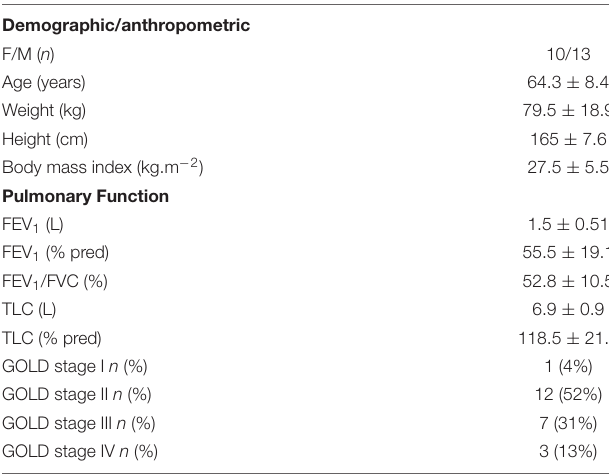
TABLE 1 | Demographic, anthropometric, and pulmonary function data of COPD